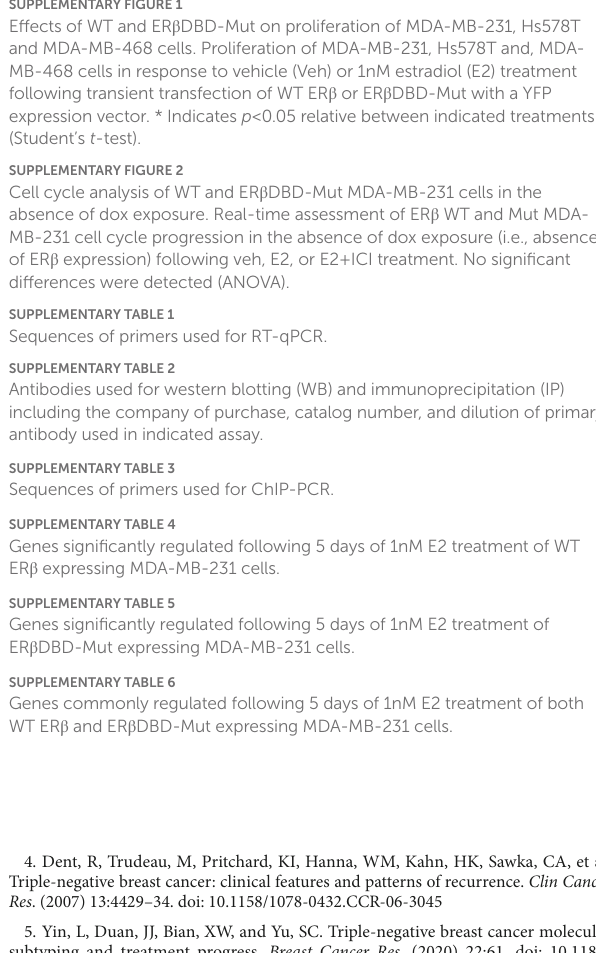
SUPPLEMENTARY FIGURE 1 Effects of WT and ER β DBD-Mut on proliferation of MDA-MB-231, Hs578T and MDA-MB-468 cells. Proliferation of MDA-MB-231, Hs578T and, MDA- MB-468 cells in response to vehicle (Veh) or 1nM estradiol (E2)